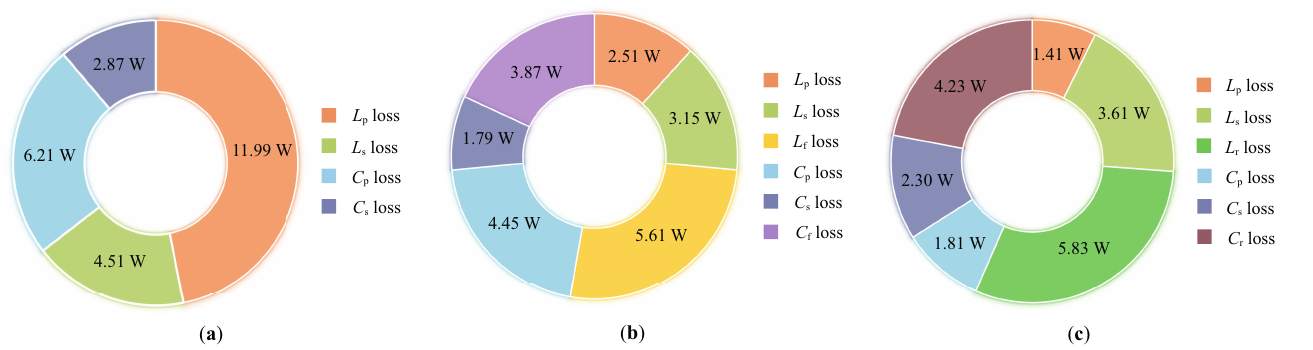
Figure 9. Power losses of the topology in ( a ) the 2-coil system, ( b ) the LCC-S-compensated 2-coil system, and ( c ) the proposed system.